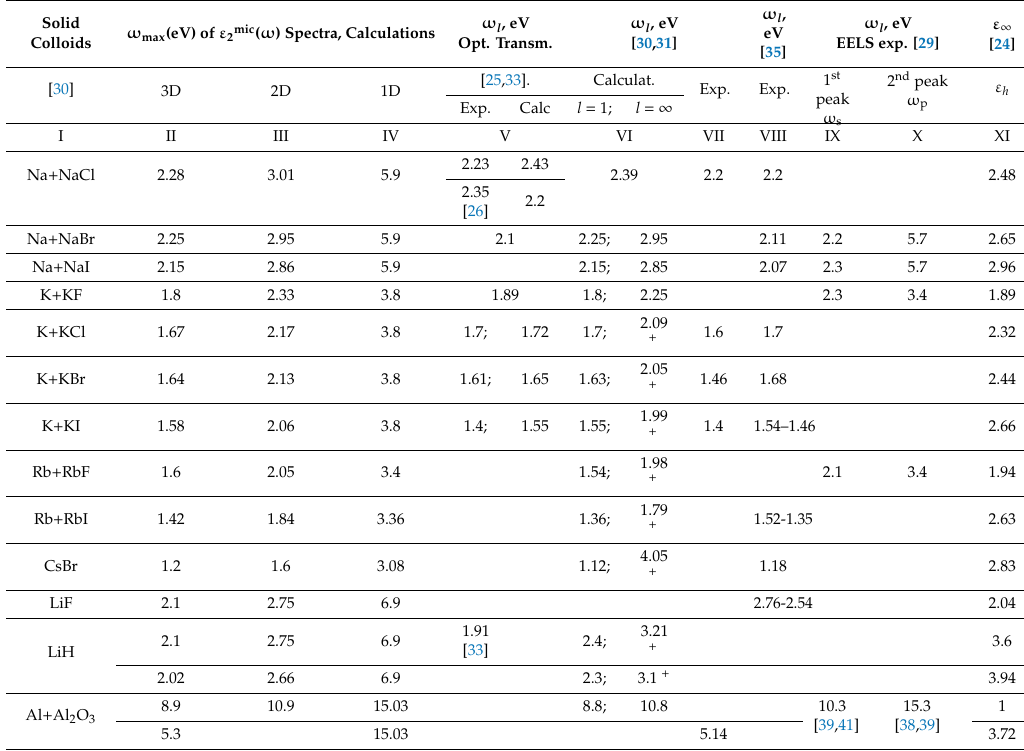
Table 2. Peak positions (eV) of optical and energy loss spectra for small metal particle (at a << λ ) colloids. Solid ω max (eV) of ε 2mic ( ω ) Spectra, Calculations ω l , eV Colloids [30] 3D 2D 1D [25,33]. Calculat. Exp. Exp. 1